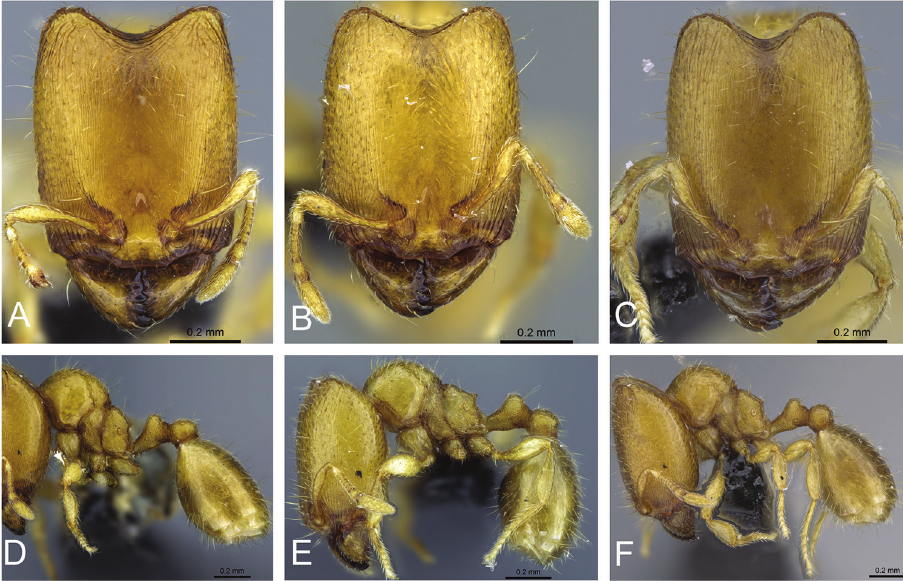
Figure 16. Head in full face view of A, D Carebara sampi (CASENT0030489) B, E Carebara raberi (CASENT0056921) C, F Carebara lova